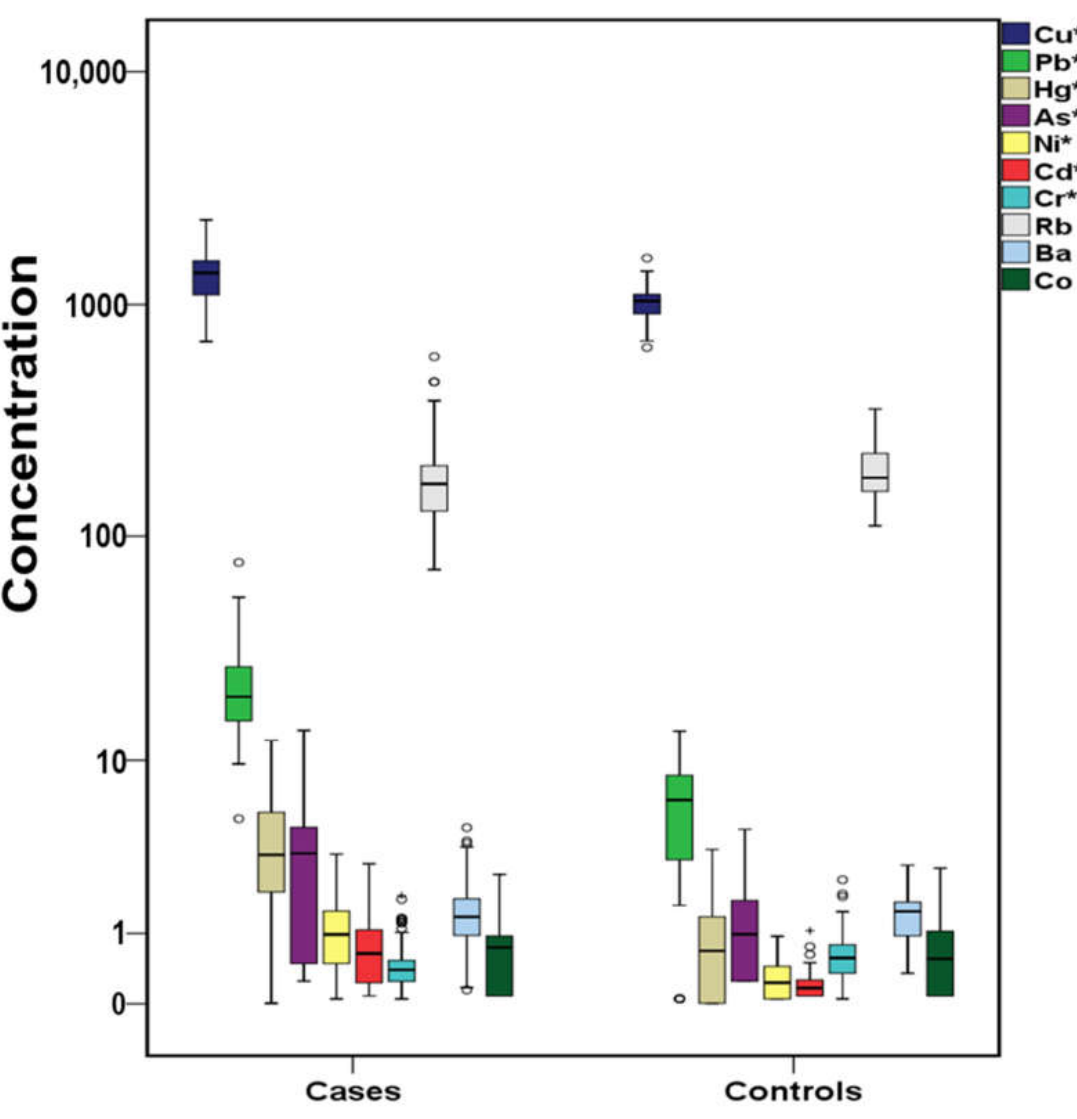
Figure 3. Variation of trace elements (μg L –1 ) both for cases and controls ( + outliers, o values above 3rd quartile and * p -value < 0.05) in logarithmic scale.